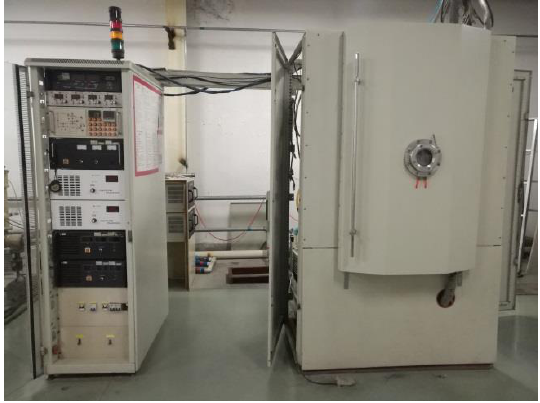
Figure 2. The magnetron sputtering equipment. Table 2. Processing parameters of magnetron sputtering aluminizing.